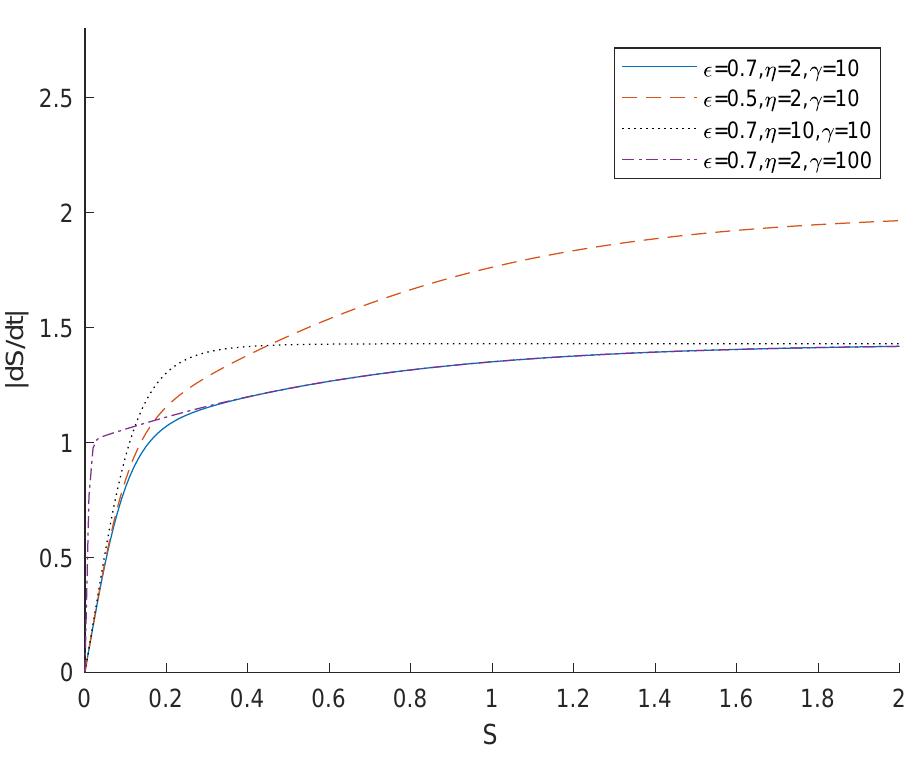
Figure 7. Reaching law under different